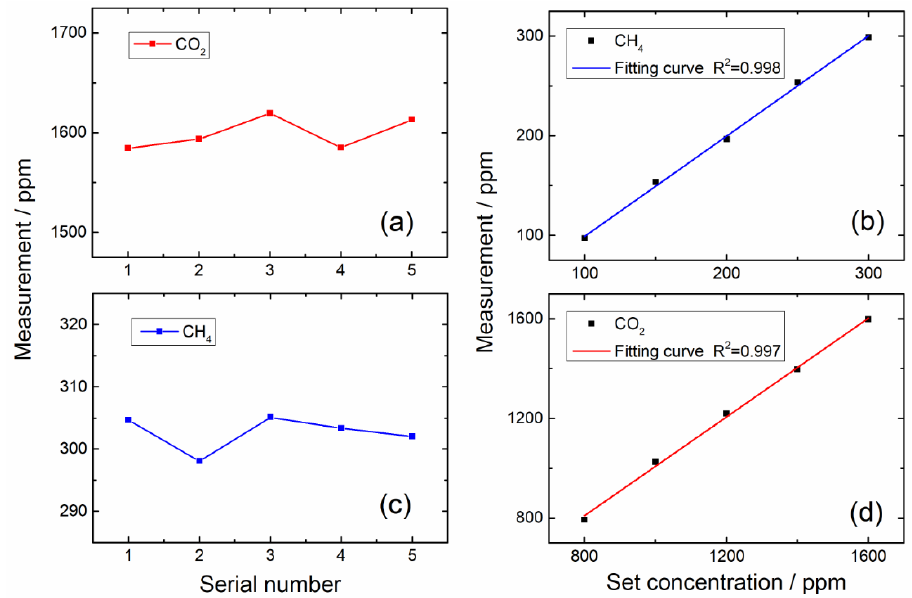
Figure 7. Best-fit mole fractions of ( a ) CH 4 and ( c ) CO 2 retrieved with multiple linear regressions. Best-fit mole fractions of ( b ) CH 4 and ( d ) CO 2 as the function of calibrated gas samples. To evaluate the detection limits of CH 4 and CO 2 , the gas mixture of 200 ppm CH 4 and